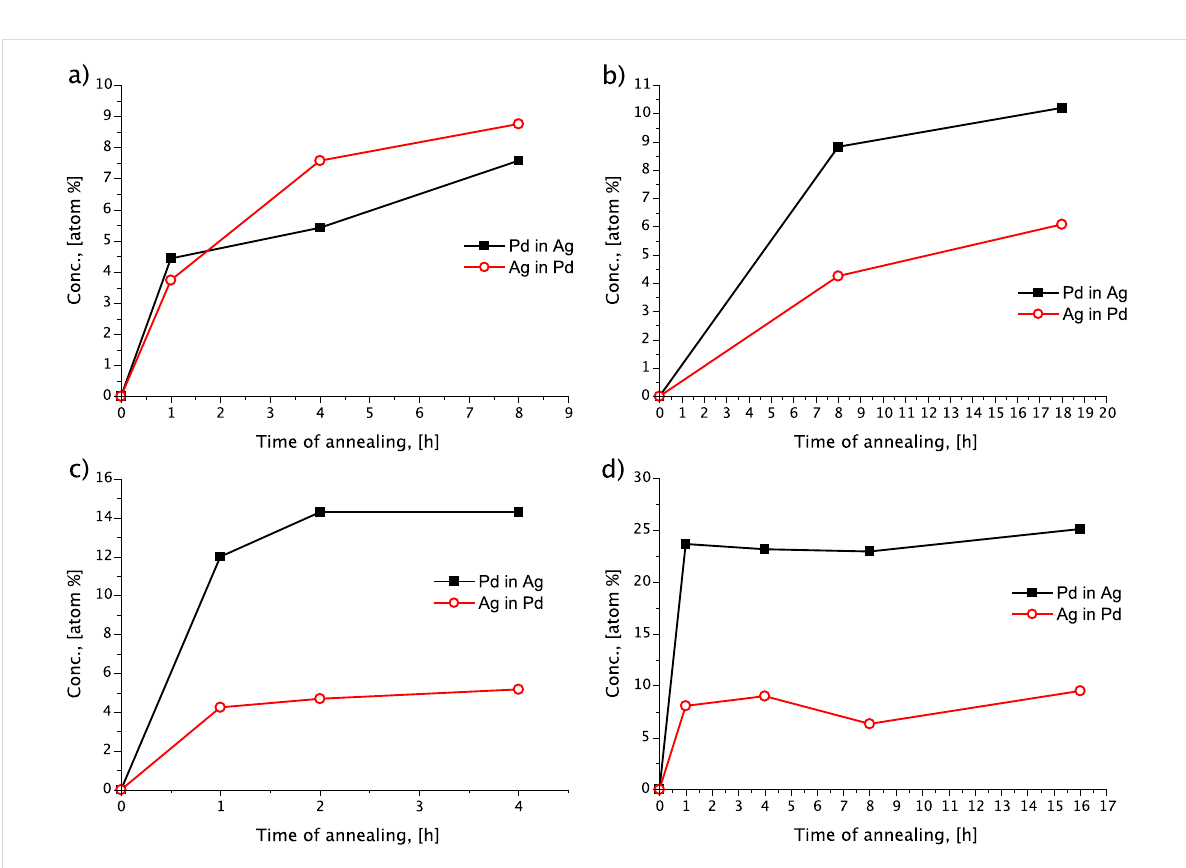
Figure 5: Saturation concentration of Pd and Ag inside the Ag and Pd layers, respectively, versus the annealing time in the Ag(15 nm)/Pd(15 nm) film at 150 °C (a), and in the Pd(30 nm)/Ag(30 nm) film as representative examples at 165 °C (b), 200 °C (c) and 280 °C